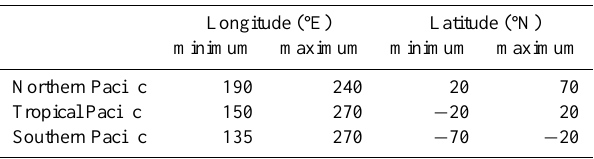
Table 4. Regions of the Pacific Ocean over which model results are compared with observations; land areas are